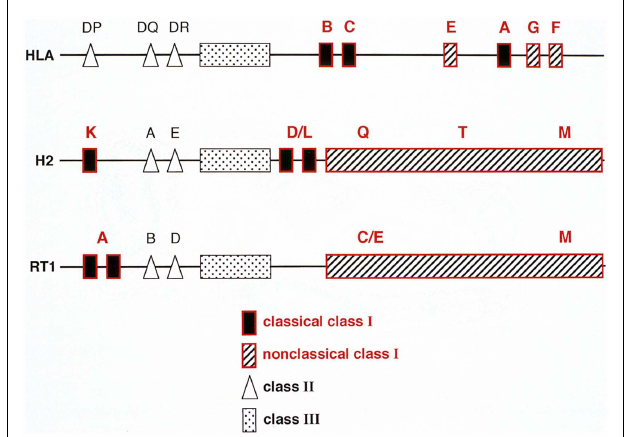
FIGURE 2 |A comparison between the genetic organization of the human (HLA), mouse (H2), and rat (RT1) MHC complex . Note that in all three species genes encoding class I, II, and III molecules are present. However, their positioning within the MHC are different: the humans lack a centromeric MHC-I encoding region whereas rats (RT1) lack mouse D/L homologs telomeric to the class II but instead has a string of genes in the centromeric part of the RT1.CEM region termed RT1.CE, some of which are expressed, can present peptides and are also recognized by NK